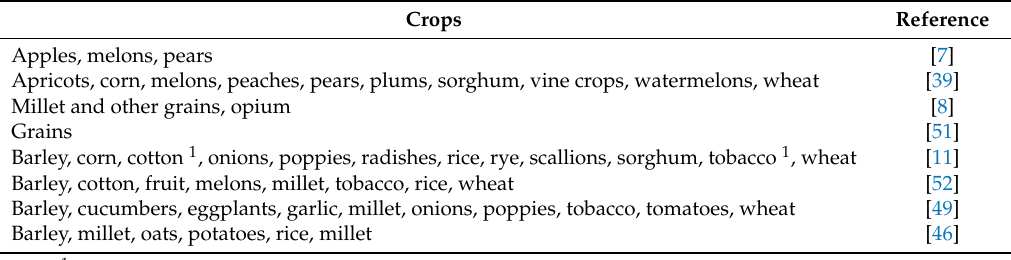
Table 1. Agricultural crops grown in the upper Ili Valley in the late 18th and early 19th